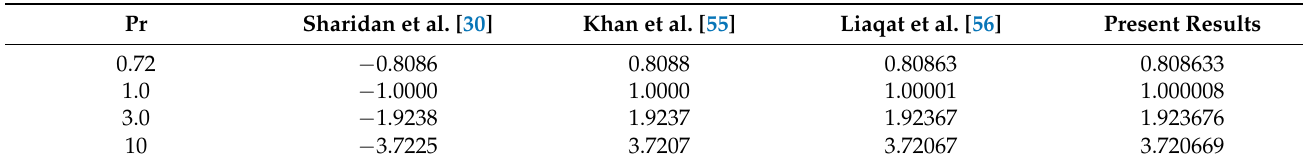
Table 4. θ (cid:48) ( 0 ) via Pr when λ = Ω = γ = (cid:101) = Q s = M = β = Φ = 0.0, χ 1 = 1.0.